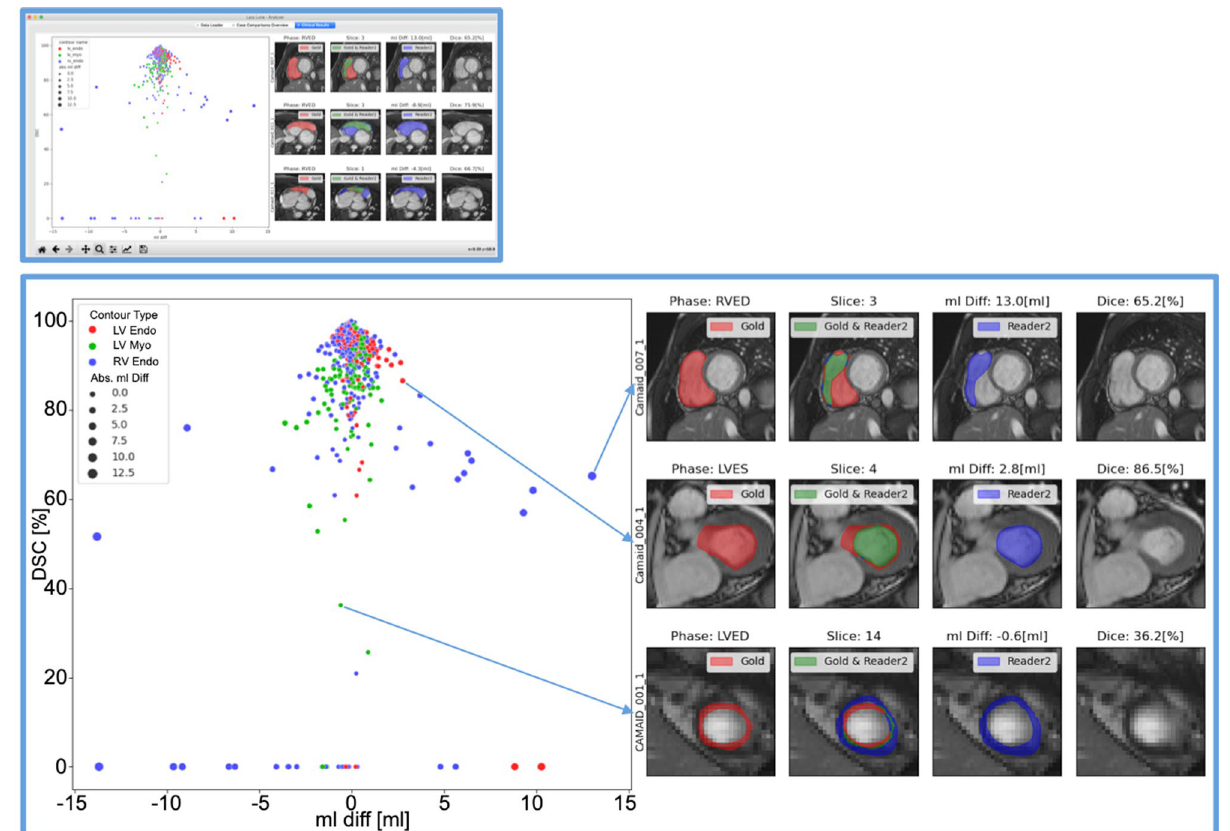
Figure 4. Interactive Correlation Plots of Segmentation Comparisons. Caption: The above window shows the interactive plot in the GUI. Below the plot is enlarged. Every point represents a contour comparison as millilitre difference and Dice value. Its colour distinguishes LV endocardial contour (red), LV myocardium (green) and RV endocardial contour (blue) contours. The point size represents the absolute millilitre difference. On the right visualizations of the comparisons are presented. The arrows show where they were selected from within the correlation plot. GUI: Graphical user interface, RV: Right ventricle, LV: Left ventricle, ES: End systole, ED: End diastole, Endo: Endocardial contour, Myo: Myocardial contour, Abs. ml diff: Absolute millilitre